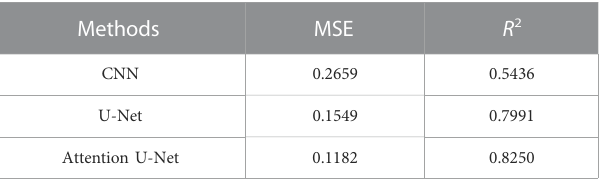
TABLE 3 MSE, R 2 between inversion results and actual acoustic